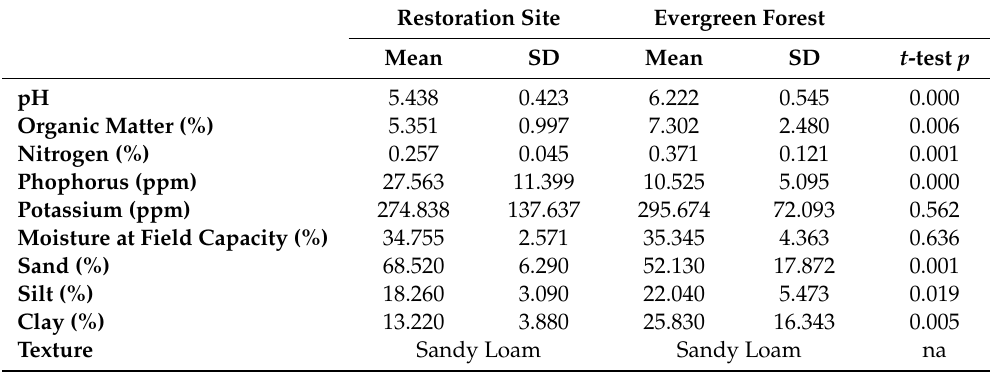
Figure 3. Mean monthly rainfall data for 1997–2013 (three tipping bucket automatic recording rain gauges at Huai Kog-Ma Watershed Research Station, Chiang Mai Province, 1,400 m a.s.l., 9 km away from the study site) (source [3]). Table 1. Soil conditions in the restoration site ( n = 16) and nearby old-growth forest ( n = 20) at the same altitude (source: [4])